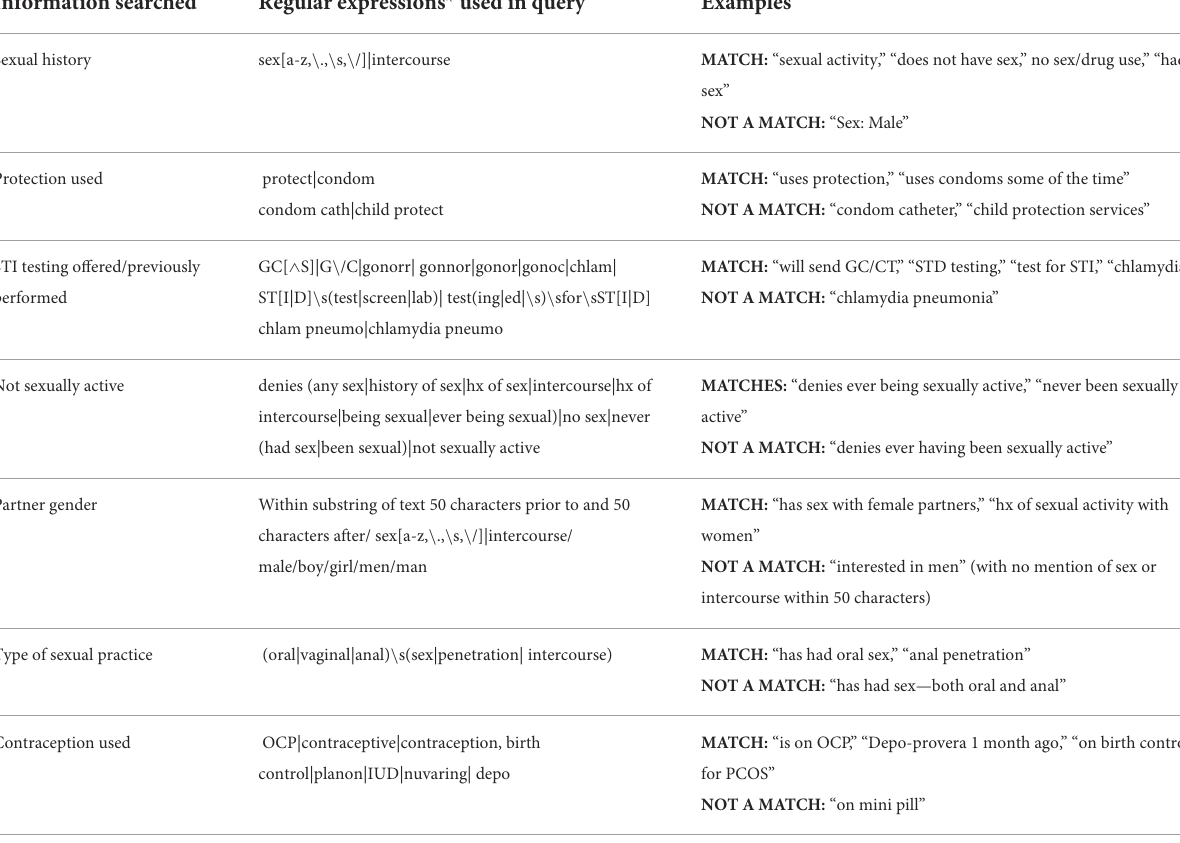
TABLE 1 Regular expressions used in final rule-based natural language processing algorithm.